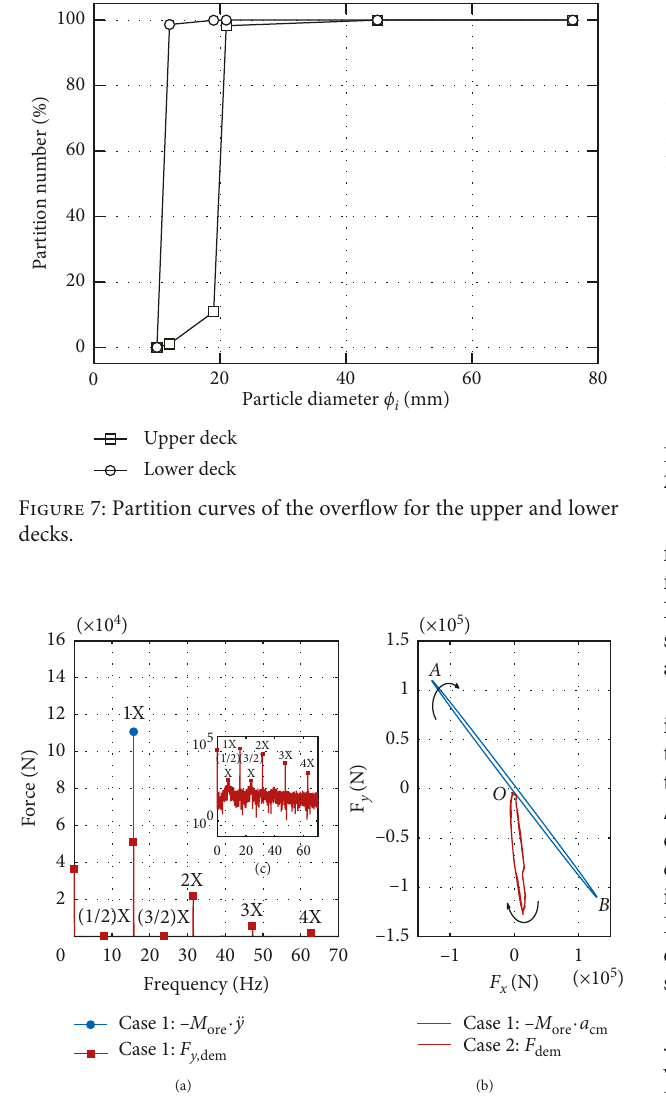
Figure 8: Force comparison: (a) frequency spectrum in y , (b) orbit, and (c) logarithmic spectrum of F y, . dem Arrows indicate the variation in each force over time. In